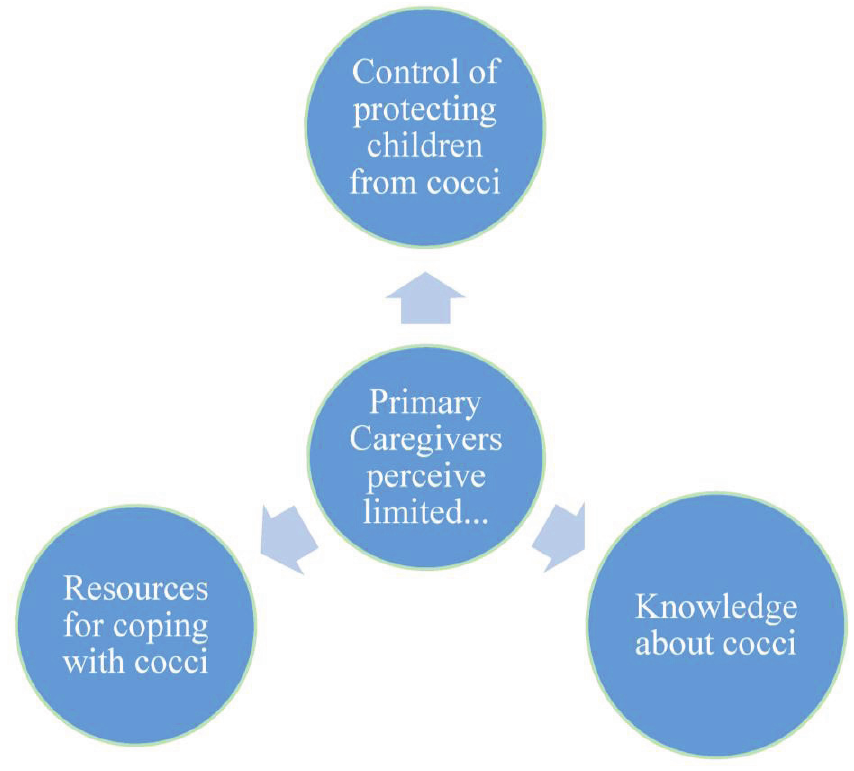
Figure 1. Perceptions of primary caregivers of children with